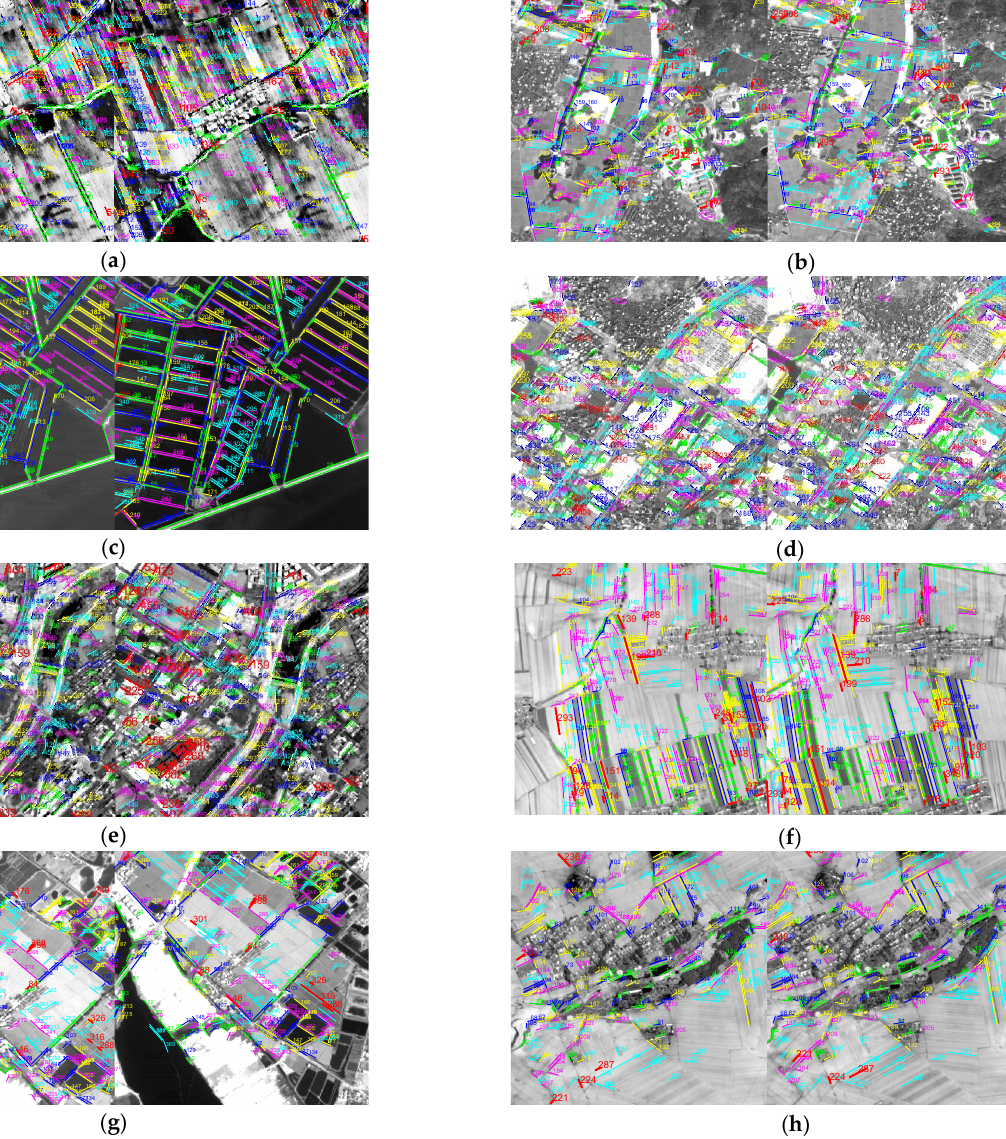
Figure 14. Results of line segment matching using our approach for 8 image pairs. The red lines indicate incorrect matches and lines in other colors indicate correct matches ( a ) Matches: 550; accuracy: 96.36% ( b ) Matches: 445; accuracy: 95.28% ( c ) Matches: 357; accuracy: 98.60% ( d ) Matches: 489; accuracy: 91.82% ( e ) Matches: 514; accuracy: 92.41% ( f ) Matches: 352; accuracy: 93.47% ( g ) Matches: